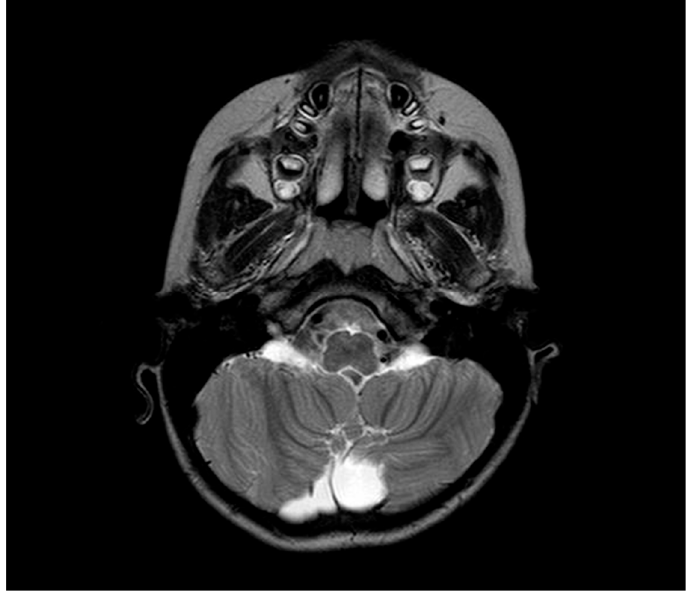
Figure 3. Retrocerebellar cystic ectasia in axial T2 weighted section.